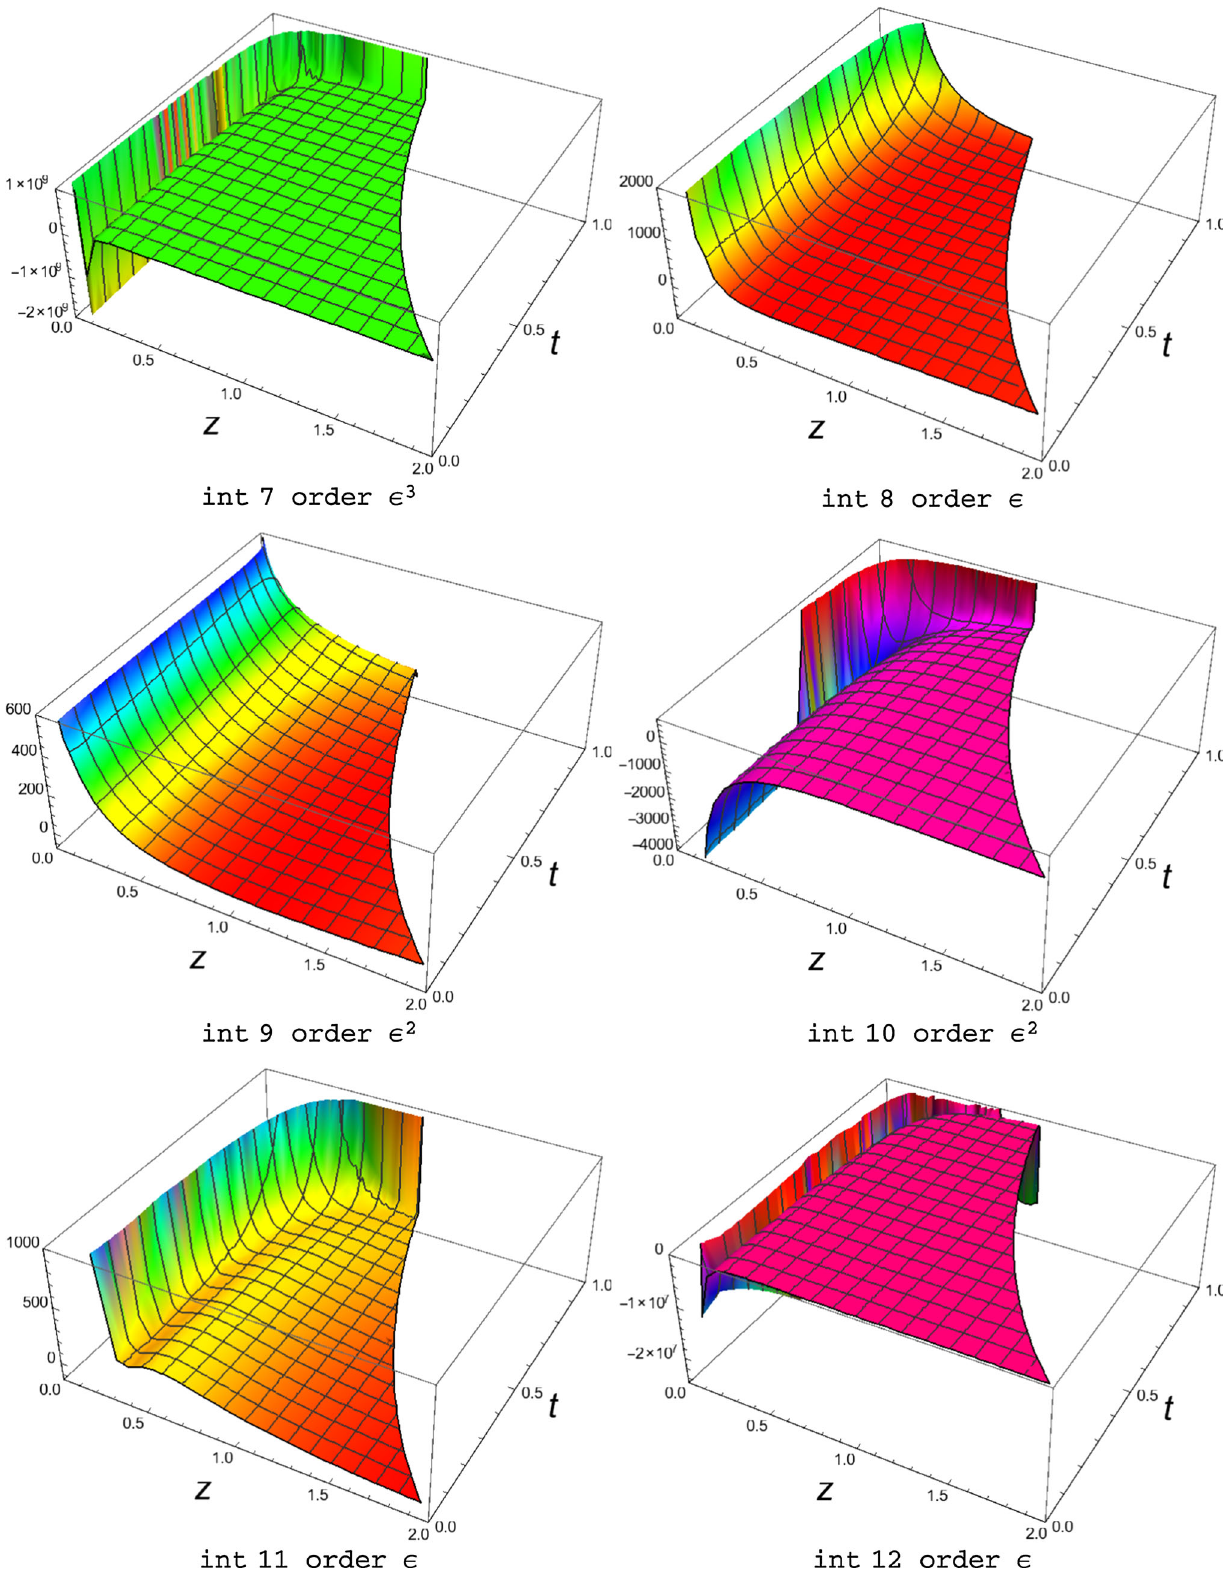
Fig. 6 Plots of the first order in (cid:3) which contains GPLs of weight four for the MIs ˆ I 7 ,..., ˆ I